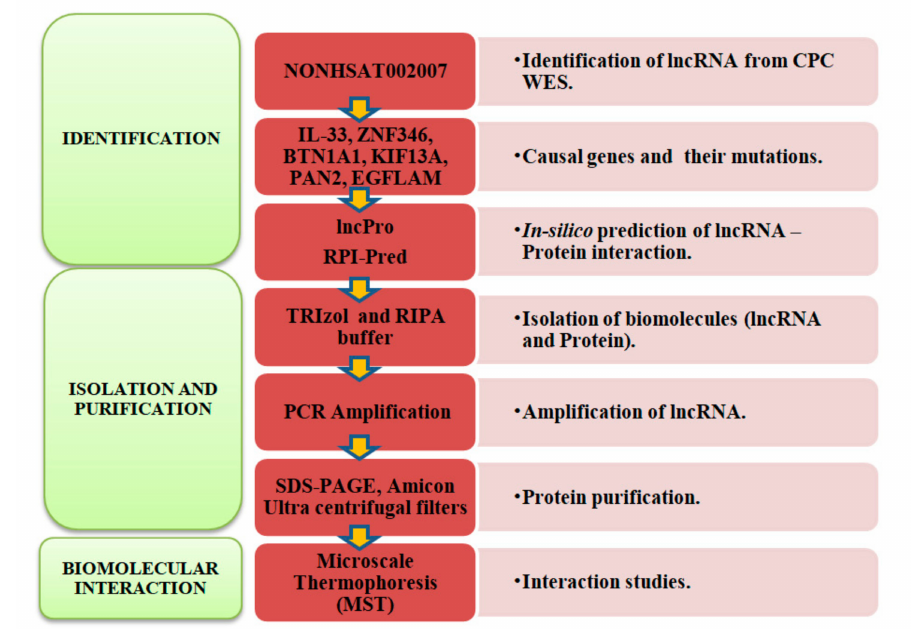
Figure 4. Flow chart demonstrating the methodology to characterize the lncRNA-protein